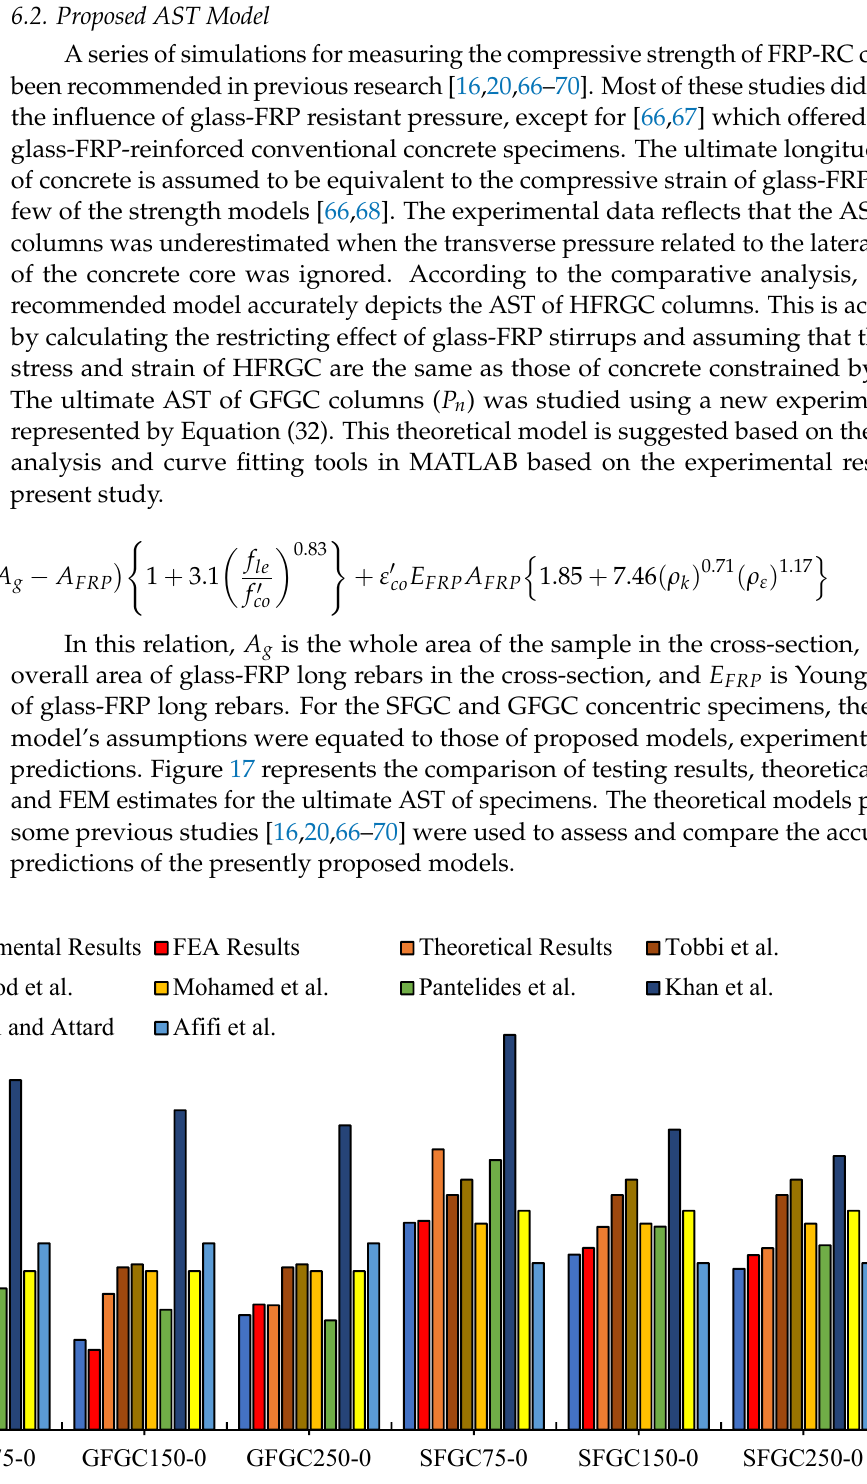
Figure 17. Comparison of testing results, theoretical estimates, and FEM predictions of ultimate AST of samples.